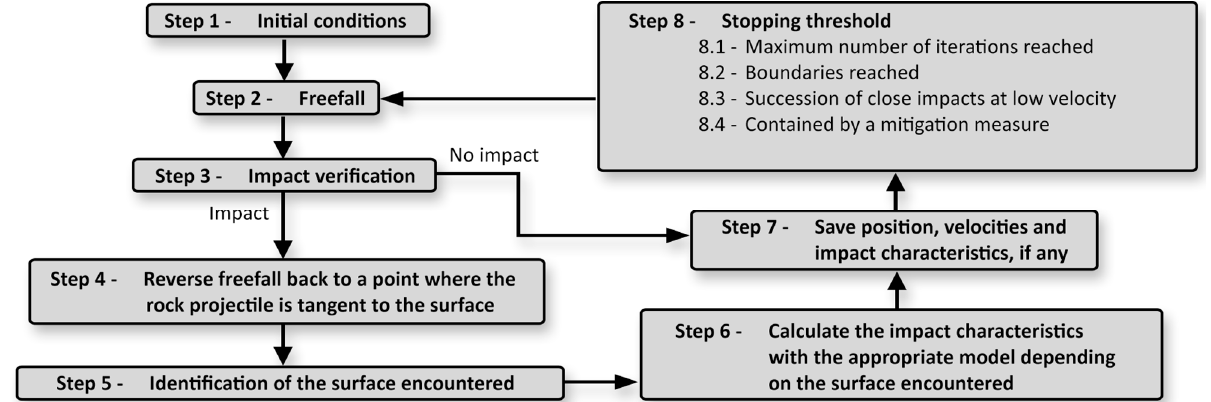
Figure 6. Main steps of the impact-detection algorithm on point clouds.